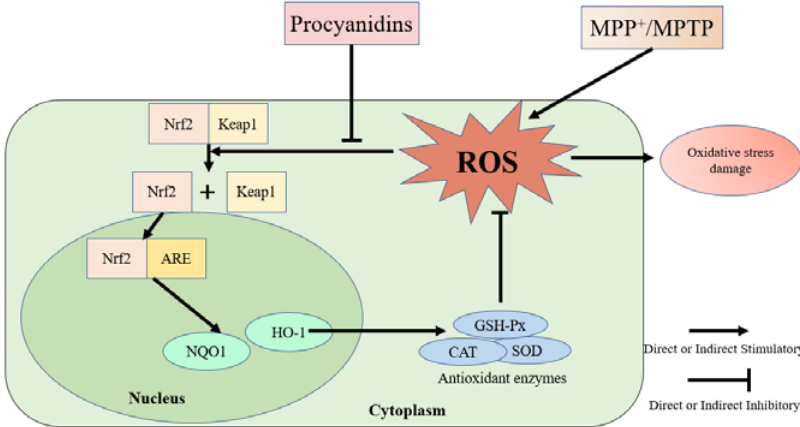
Figure 11. Schematic diagram of the protective effects of procyanidins in PD models.